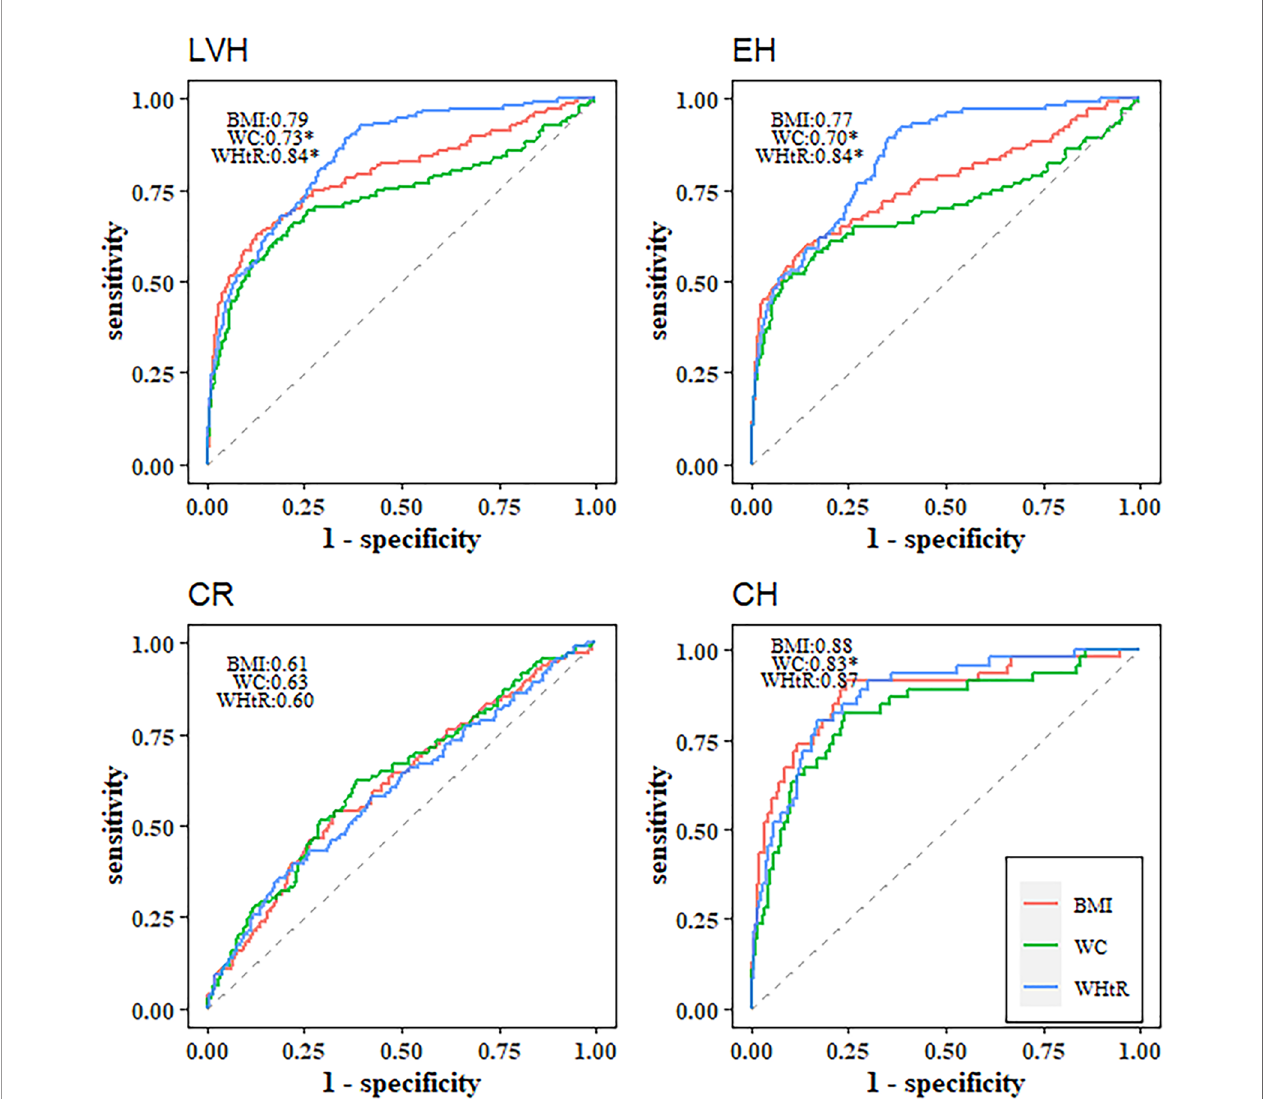
FIGURE 1 | Receiver operating characteristic curves of BMI, WC and WHtR for identifying left ventricular hypertrophy and left ventricular geometric remodeling. *Statistically signi fi cant difference in area under the operating characteristic curves as compared with BMI. LVH, left ventricular hypertrophy; CR, concentric remodeling; EH, eccentric hypertrophy; CH, concentric hypertrophy; BMI, body mass index; WC, waist circumference; WHtR, waist-to-height